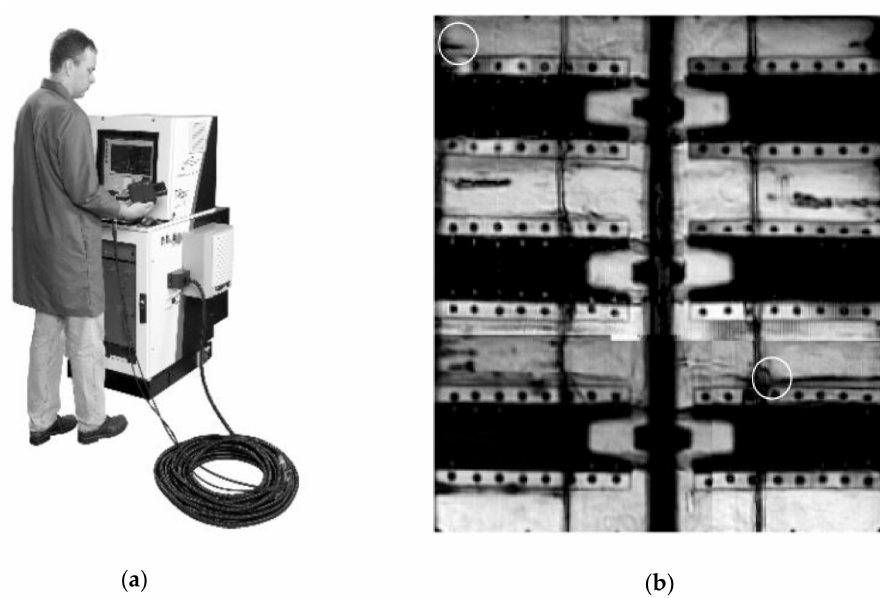
Figure 3. Pulsed THz imaging of space shuttle foam for defect detection: ( a ) Photograph of the equipment. The transceiver head is connected to the main control unit via an umbilical cord; ( b ) THz image of a test panel with voids in the spray foam. Voids appear as horizontal dark streaks. White circles mark the areas where the voids crack through the milled surface of the panel. Reproduced with permission from